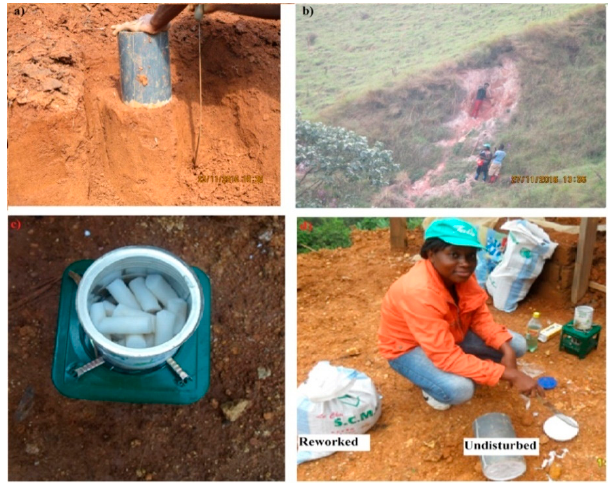
Figure 5. Sampling: ( a ) Undisturbed soil sampling method; ( b ) sampling in the major landslide found at Mbingo; ( c ) stove used to melt candles; ( d ) reworked and undisturbed samples ready for laboratory analyses.